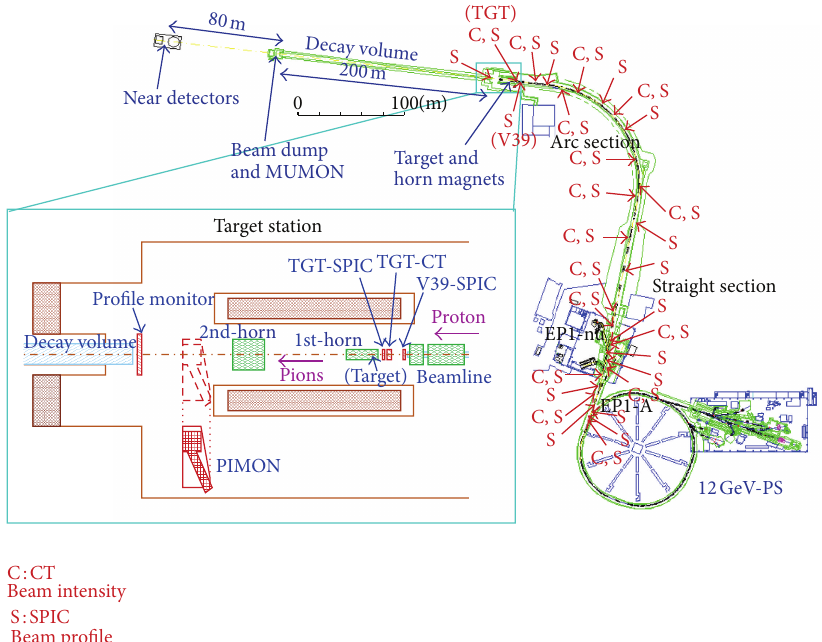
Figure 1: A schematic of the K2K beamline that includes the primary proton beamline.